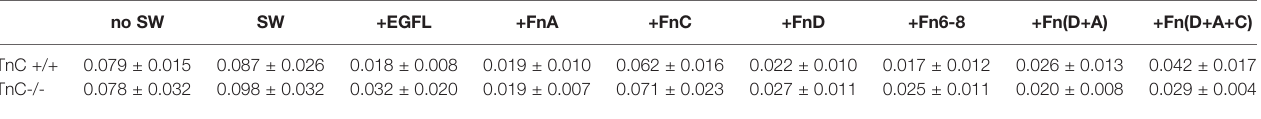
TABLE 3 | Mean values ± standard deviations of proliferation rate in the astrocyte scratch wound assay. no SW